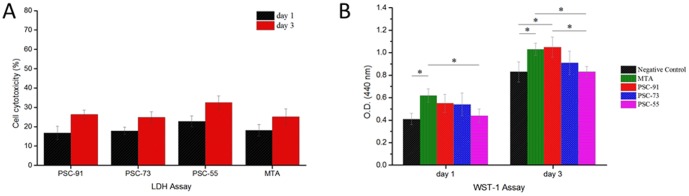
(A) Cytotoxicity assessment of PSC-91, PSC-73, PSC-55 and mineral trioxide aggregate (MTA) by LDH assay according to ISO-10993 protocol standard. All tested cements on dental pulp cells were evaluated by LDH assay on 1day and 3 days. Each bar illustrated average absorbance (A490 nm) ± SD. No significant differences between PSC-91, PSC-73 and MTA (P>0.05); (B) Cell viability evaluation by WST-1 assay. Each bar illustrated average absorbance (A440 nm) ± SD.